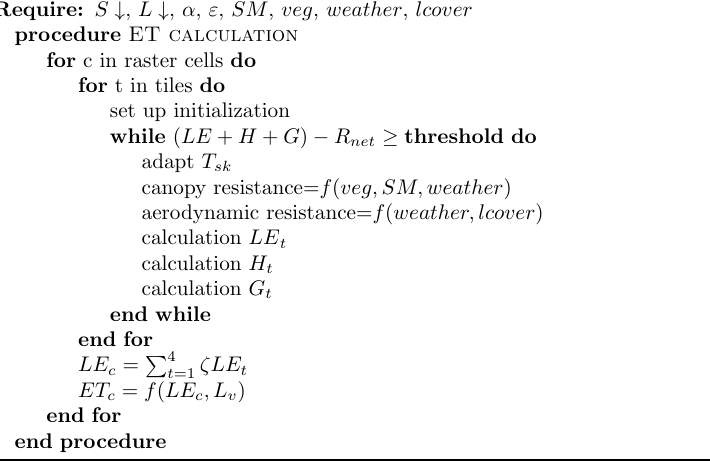
Figure 1. General procedure for ET estimation where: LE t : latent heat flux; H t : sensible heat flux; G t ground heat flux; α : albedo; S and L : downwelling short and long wave solar radiation; ↓ ↓ ε : emissivity; T sk : skin temperature; SM : soil moisture; weather : meteorological forcing; lcover : parameters related to land